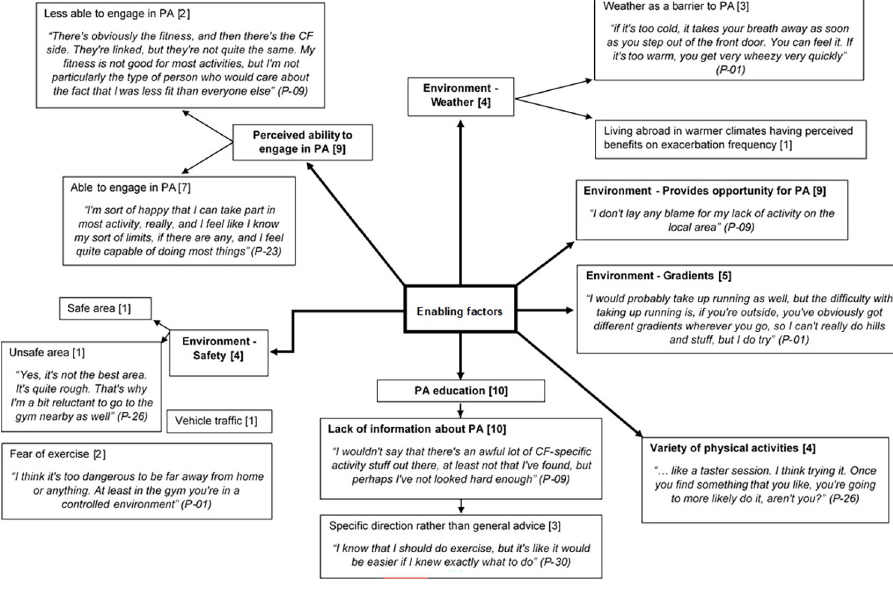
Fig 4. Pen profile displaying enabling factors (n = 11) with illustrative quotes, associated participant number and frequency count provided in square brackets.